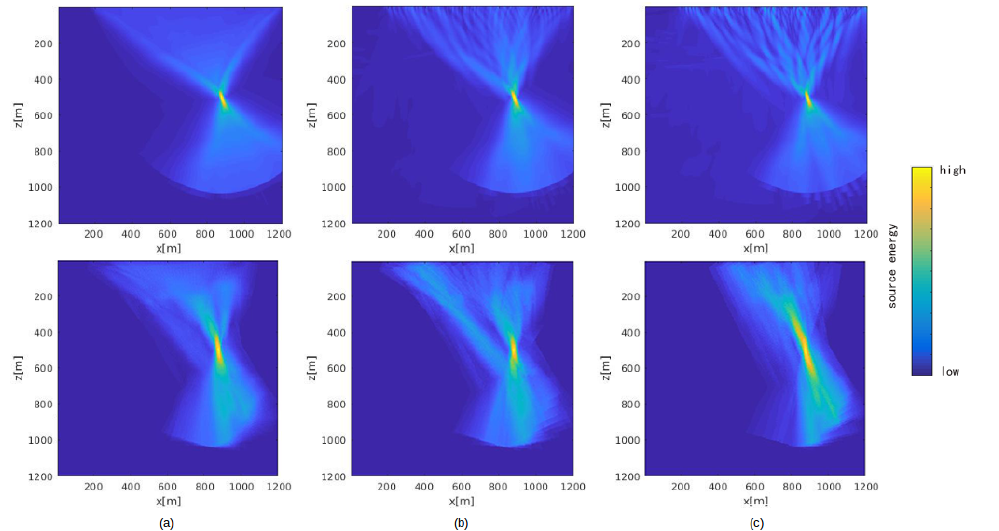
Figure 13. FDTD-TRI ( first row ) and GB-TRI ( second row ) energy maps under different packet loss rates: ( a ) 0% packet loss; ( b ) 40% packet loss; ( c ) 70% packet